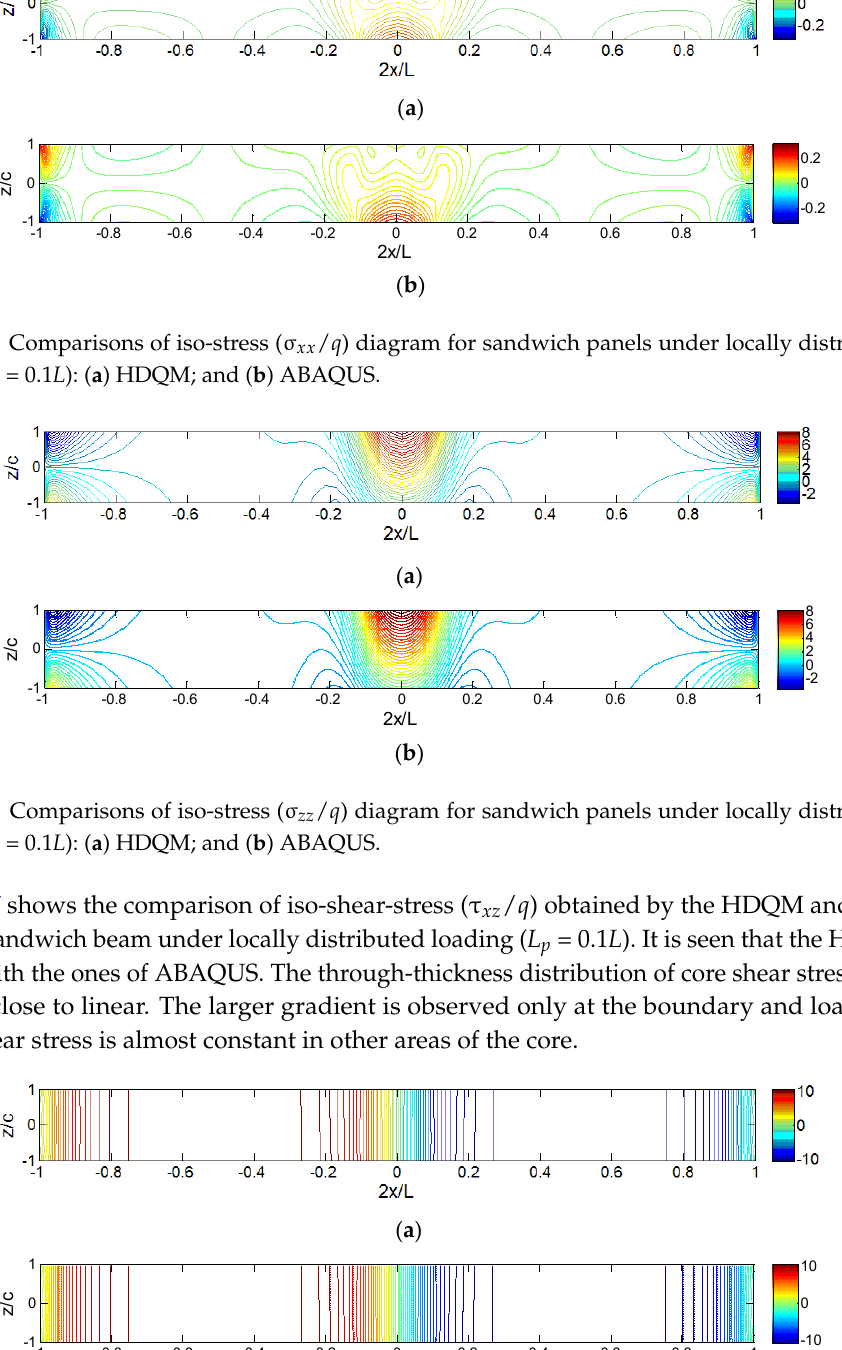
Figure 4. Comparisons of iso ‐ displacement ( / distributed loads ( L p = 0.1 L ): ( a ) HDQM; and ( b ) ABAQUS.